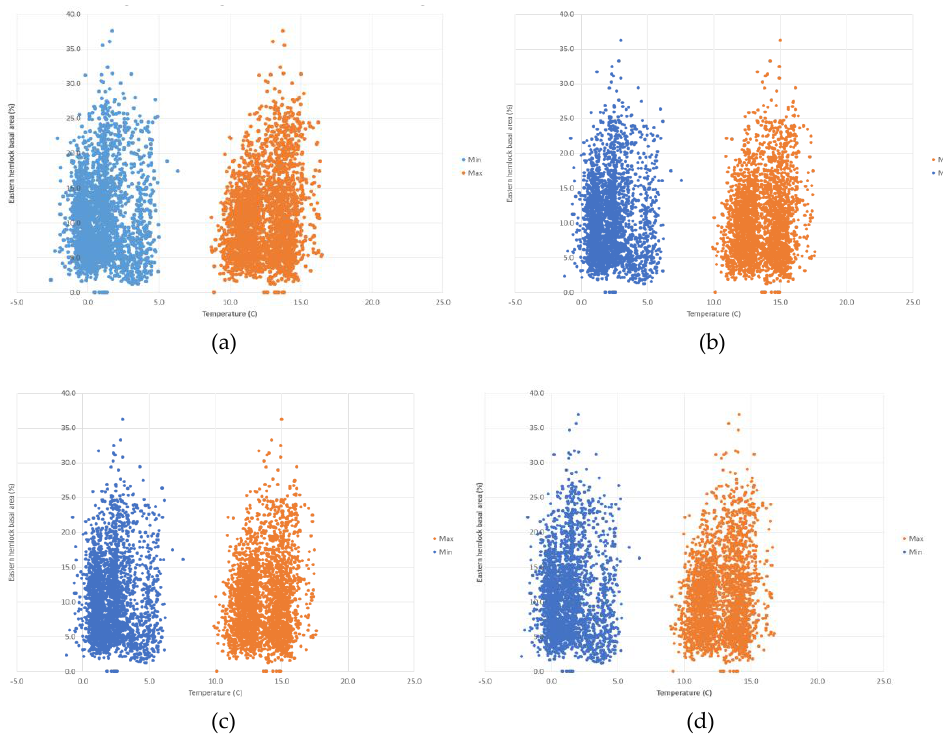
Figure 6. Projected values for Tsuga canadensis basal area and minimum and maximum temperature for ( a ) RCP 4.5 (2050), ( b ) RCP 4.5 (2100), ( c ) RCP 8.5 (2050), and ( d ) RCP 8.5 (2100). Forests 2017 , 8 , 285